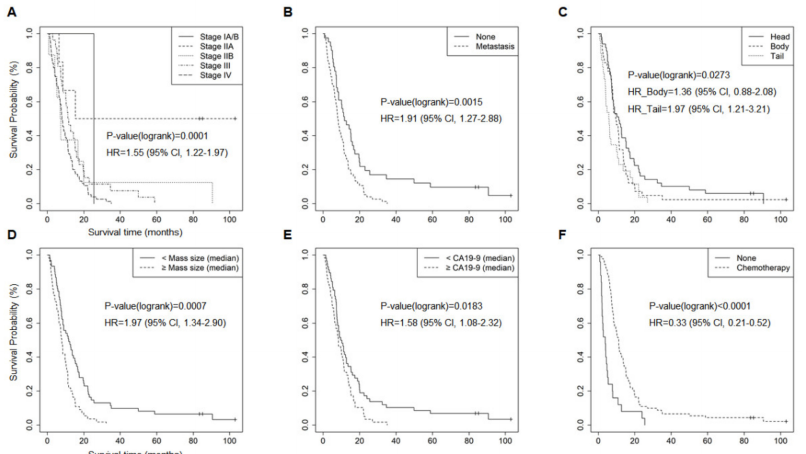
Figure 2. Kaplan–Meier plots for clinical factors significantly associated with survival. The Kaplan–Meier plots demonstrate six clinical factors with a significant ( p < 0.05) association with the survival of patients with PDAC. ( A ) Stages, ( B ) metastasis, ( C ) tumor location, ( D ) tumor mass size, ( E ) CA19-9 level, and ( F ) chemotherapy. Hazard ratio (HR), confidence interval (CI), and p -value were obtained from univariate Cox proportional hazard